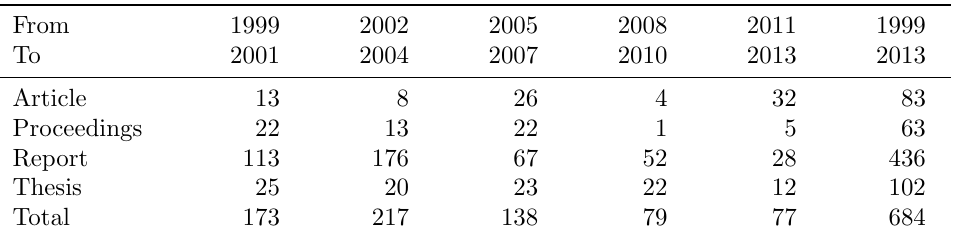
Table 1: ¨Asp¨o publication pattern by type